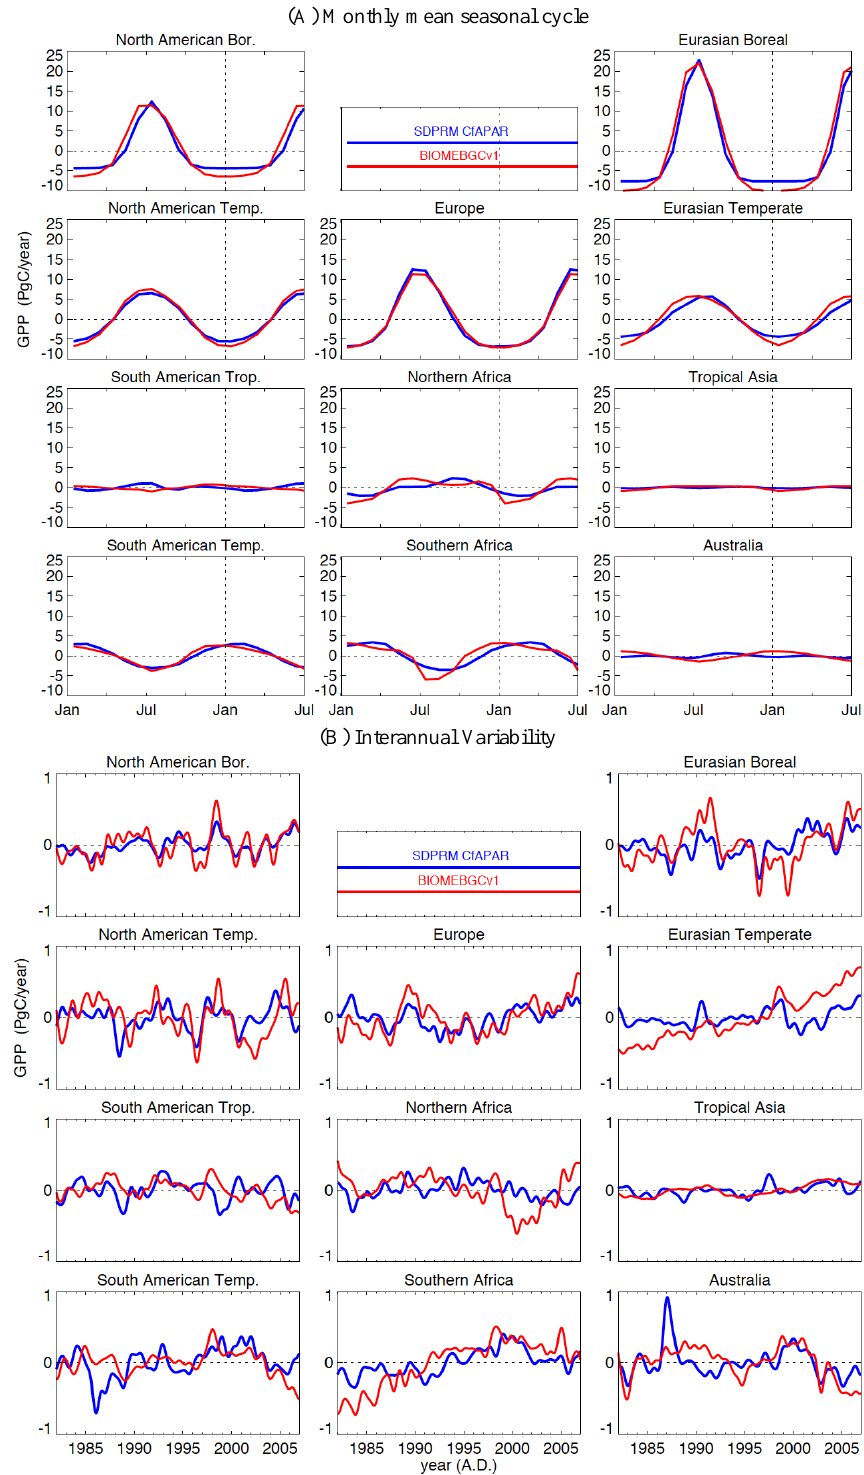
Fig. 8. The comparison between the estimated GPP from SDPRM-CfAPAR [Blue], and from BIOME-BGCv1 [Red] for the monthly mean seasonal cycle (A) and for the interannual variability (B) . The time series are integrated over 11 land regions (for the map of the regions see Fig. 3) and de-seasonalized and filtered for interannual variability (as in Rödenbeck